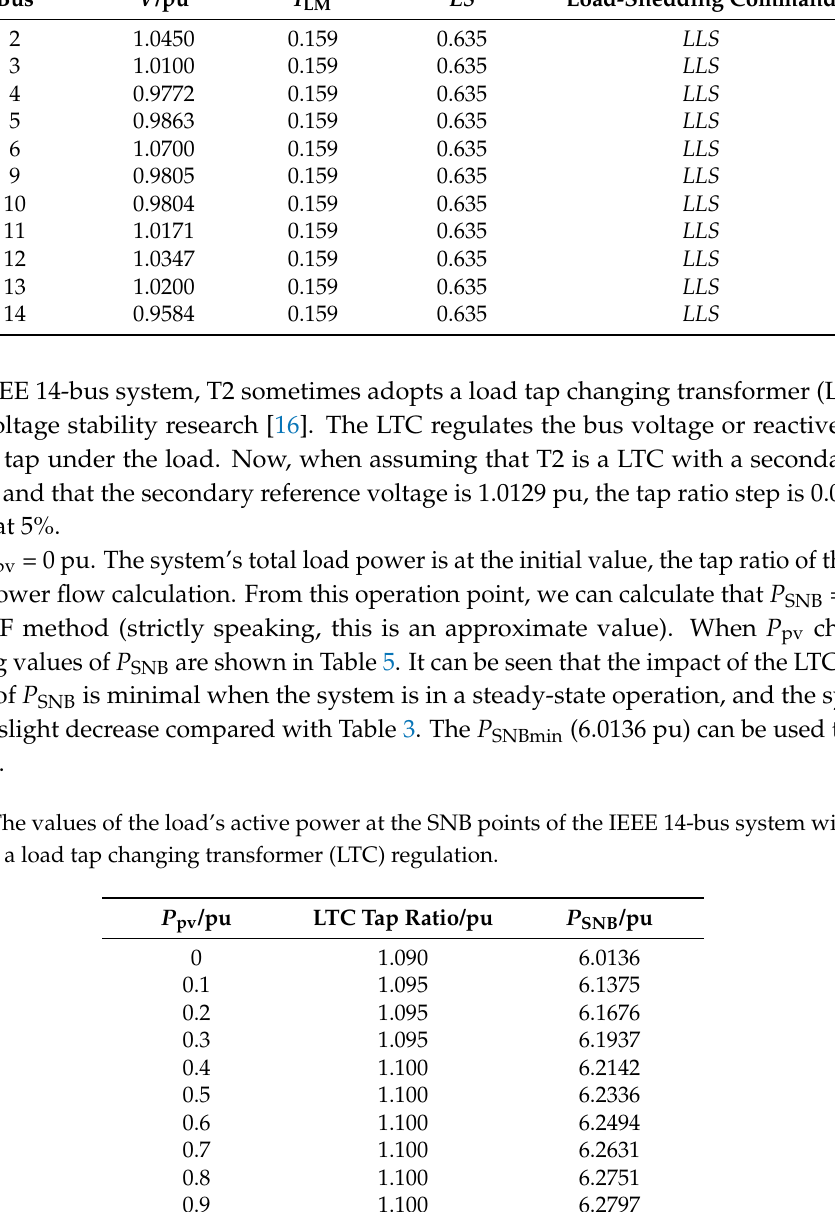
Table 4. The fuzzy outputs of all the fuzzy load-shedding controllers of the IEEE 14-bus system with PV. Bus V /pu I LM LS Load-Shedding Command 2 1.0450 0.159 0.635 LLS 3 1.0100 0.159 0.635 LLS 0.9772